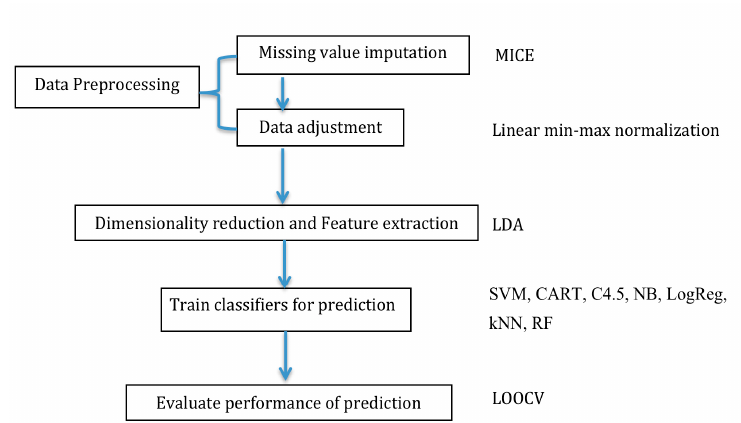
Figure 9. Data processing flow chart in this study; MICE: multivariate imputation by the chained equation; LOOCV: leave-one-out cross-validation; NB: naïve Bayes; k NN: k-nearest neighbor; SVM: support vector machine; C4.5: C4.5 decision tree; CART: classification and regression trees; RF: random forest; LogReg: logistic regression.